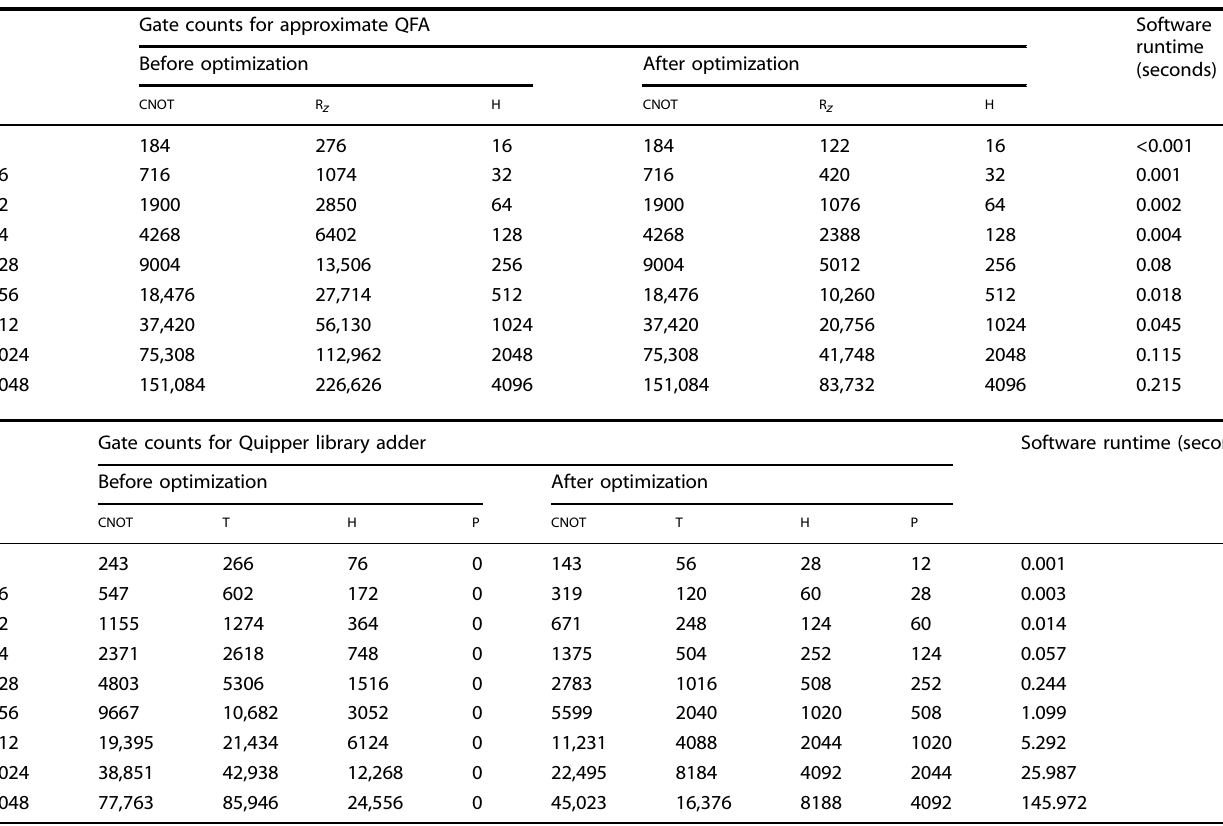
benchmarks from Table 4: Mod 5 4 , VBE-Adder 3 , CSLA-MUX 3 , RC- Adder